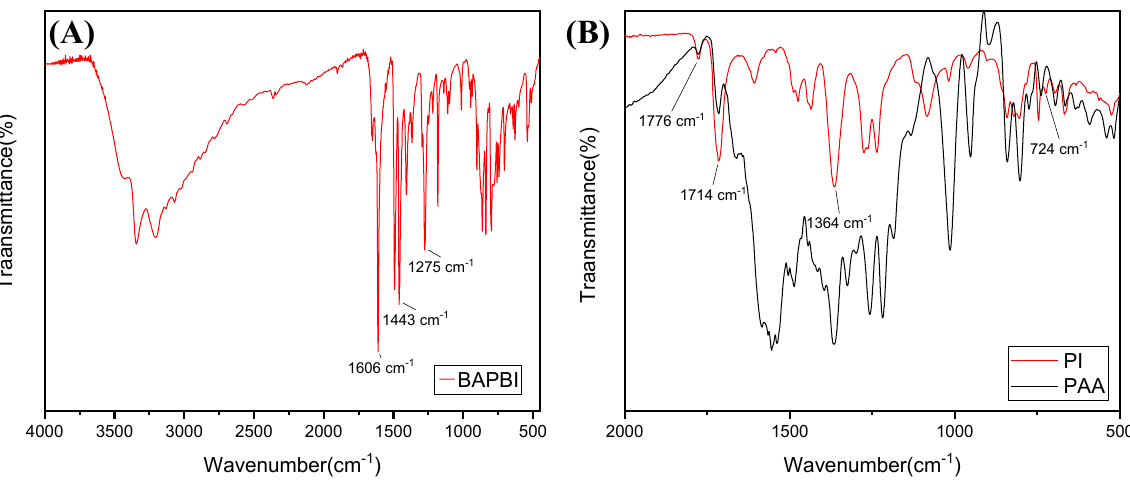
Figure 3. FT-IR spectra of ( A ) BAPBI monomer, ( B ) PAA polymer and BI-PI polymer.